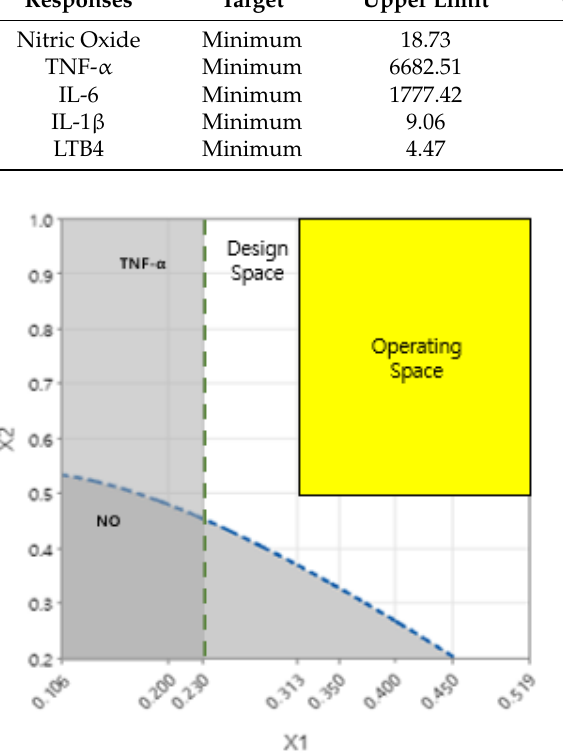
Figure 7. Design space (DS) and operating space (OS) for any combination of factors that satisfy all response criteria. The white-colored area that satisfies the criteria of the target output variable within the level of the input variable is the DS. The yellow-colored area that shows feasible values of factors satisfying all response criteria within the intersection between DS is defined as the OS. The green line and the blue line show upper limits of TNF- α and NO, respectively. The dark color area under the green and blue lines indicates that the quality of the response variable is not guaranteed. The x -axis and y -axis represent the ratio of factor GR and factor SF in each